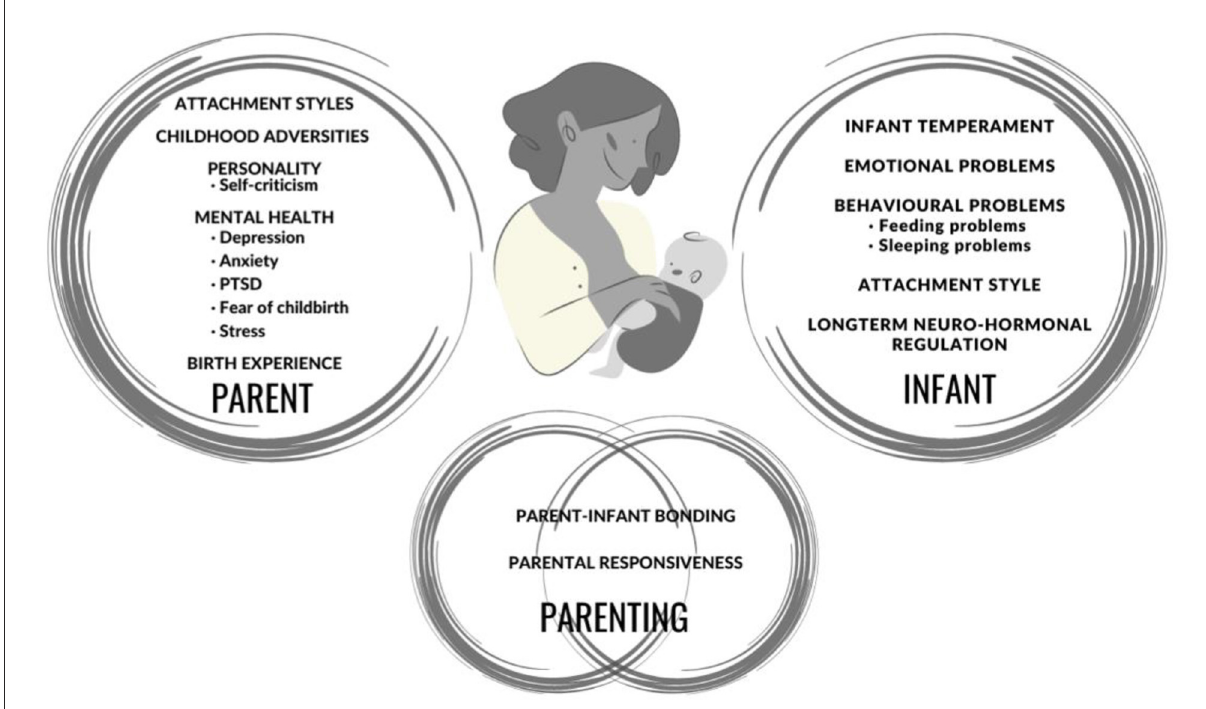
FIGURE1 Schematic overview of the constructs examined within the Research Topic. (Figure created in